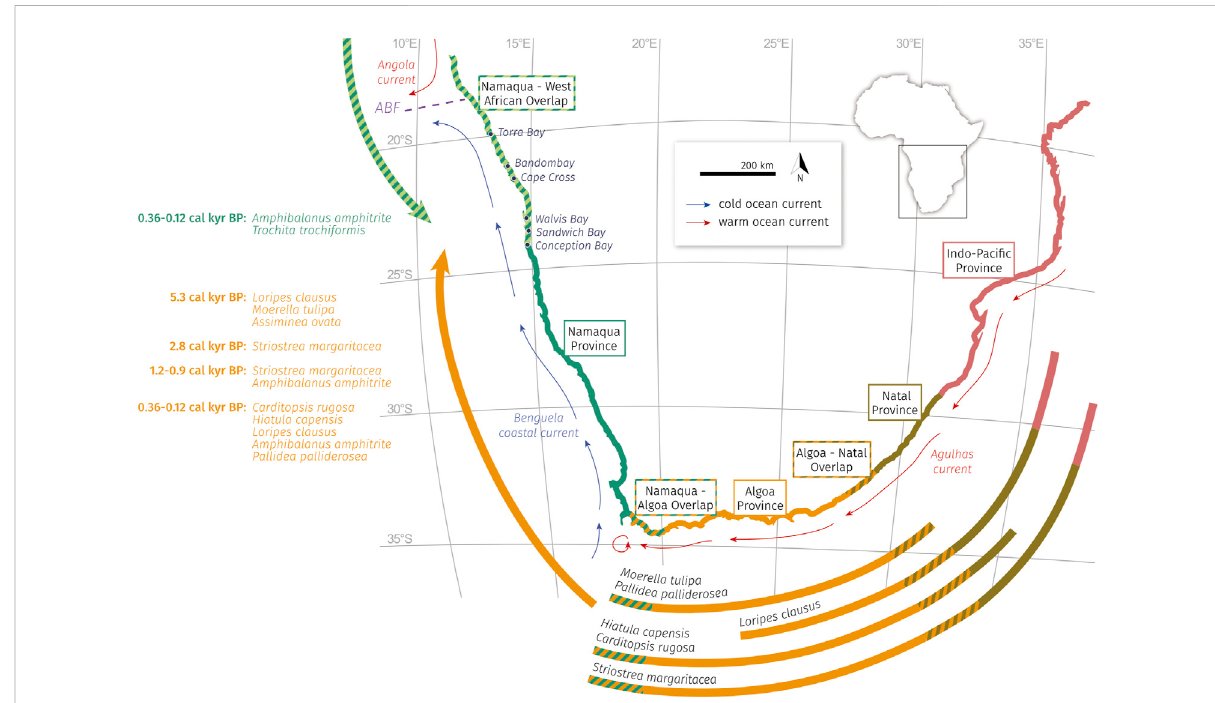
FIGURE 9 Faunal extension along the southwestern African coast since 5.7 cal ka BP. All documentedspecies werefound inthe coastal pan sediments of ConceptionBay,SandwichBay,WalvisBay,CapeCross,andTorraBay.Thebiogeographicanalysesofthisstudyresultedintheidenti fi cationofeight species from the warmer water massesof the Agulhas Current and two species that migrated from the tropical Angola basin in thenorth, both inthe distincttimeslotsof5.3 cal kyrBP,2.8 cal kyrBP,1.2 – 0.9 cal kyrBP,and0.36 – 0.12 cal kyrBP.De fi nitionofthemarineprovincesbyKilburnand Rippey